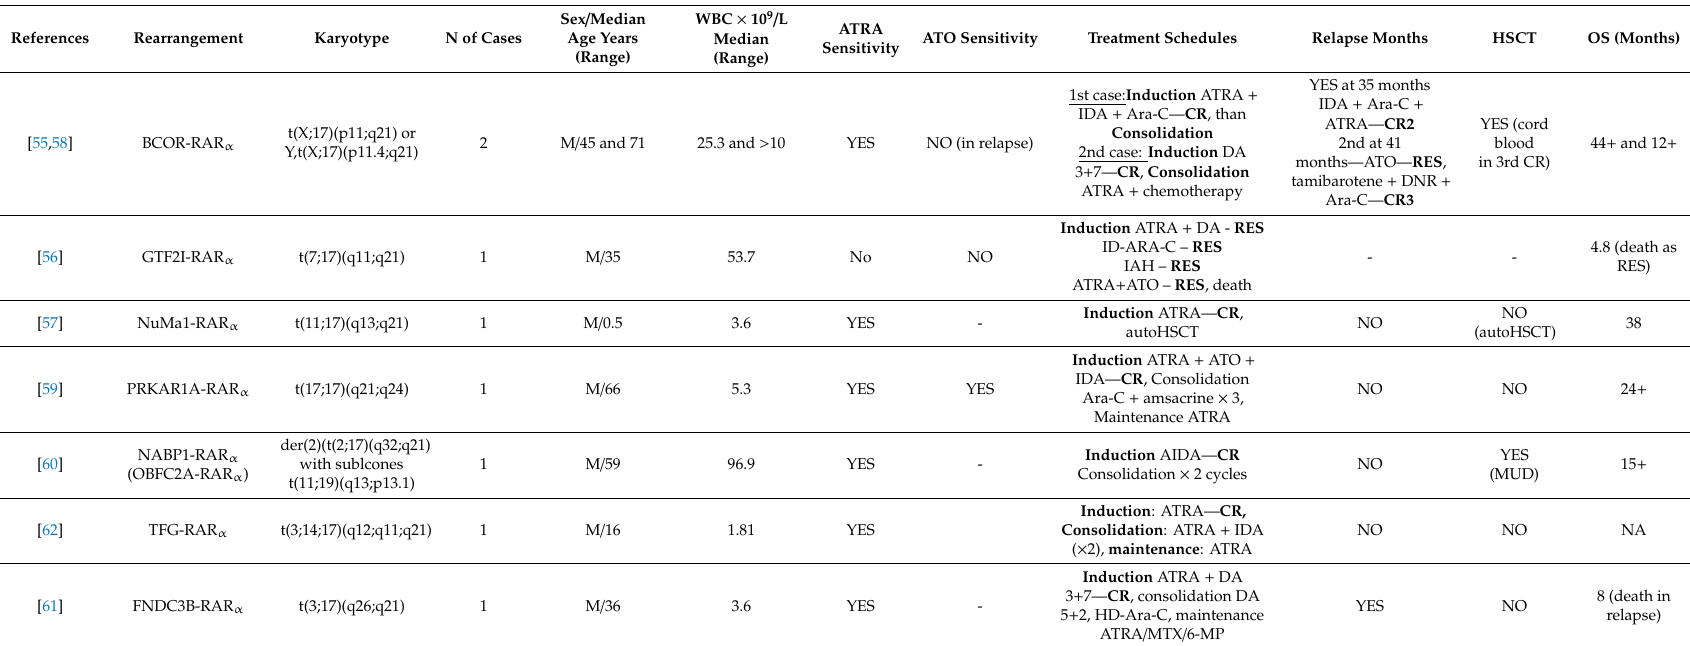
1st case: Induction ATRA + IDA + Ara-C— CR ,